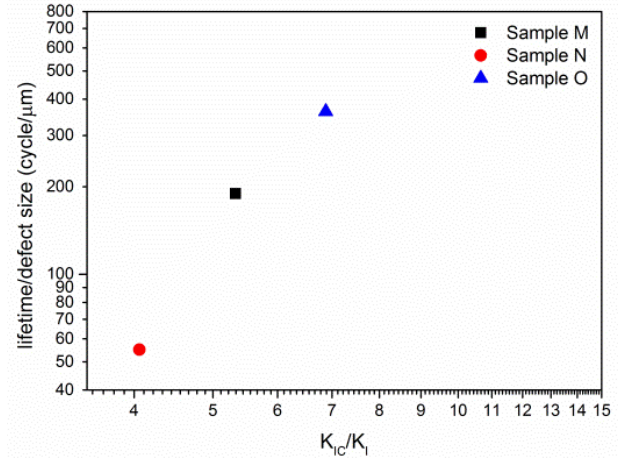
Figure 10. Plot of the lifetime t f divided by the initial crack length c as a function of the critical stress intensity factor divided by the apparent one (see Equation (7)) for the samples given in Table 3.